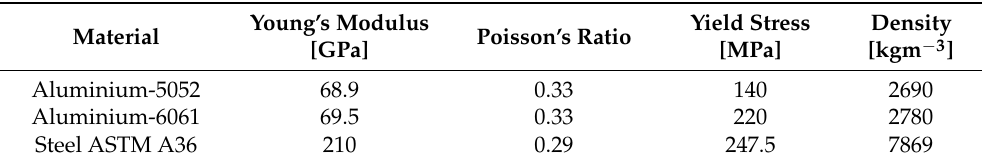
Table 1. Mechanical Elasticity and Density Properties of the aluminum alloys and steel grade used in this paper. The values are the same as the ones that were simulated in [1].